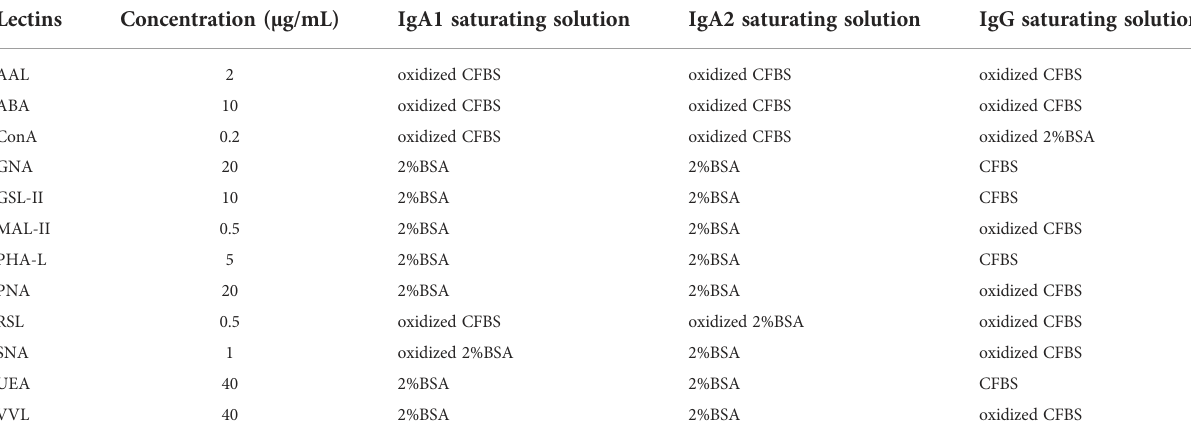
TABLE 4 Lectins, concentrations and saturating conditions used for